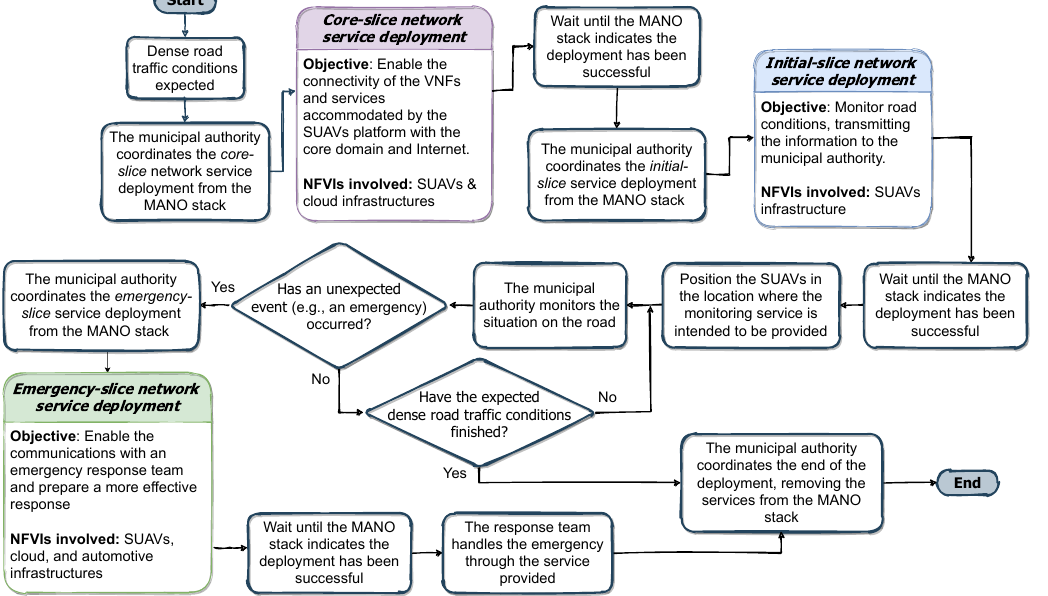
Figure 5. Flowchart of the use case and network service